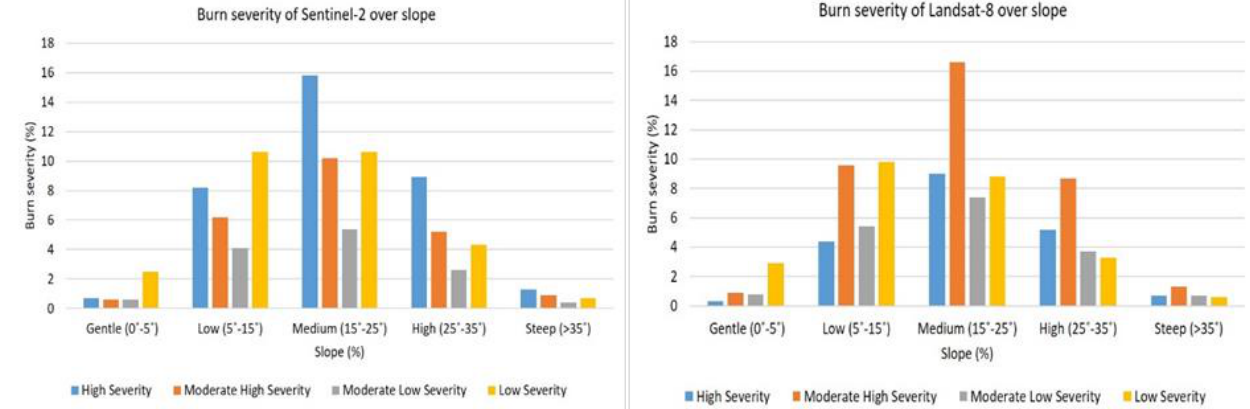
Figure 7. Spatial analysis of burn severity over slope.